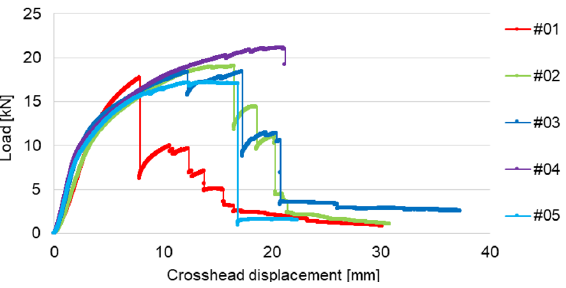
Figure 8. Load vs. crack tip opening displacement (CTOD) with the first failure F1.